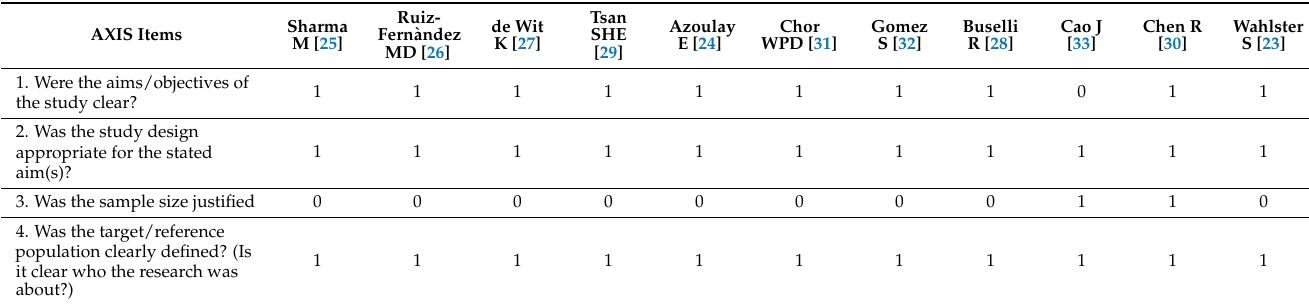
Table 4. Quality assessment